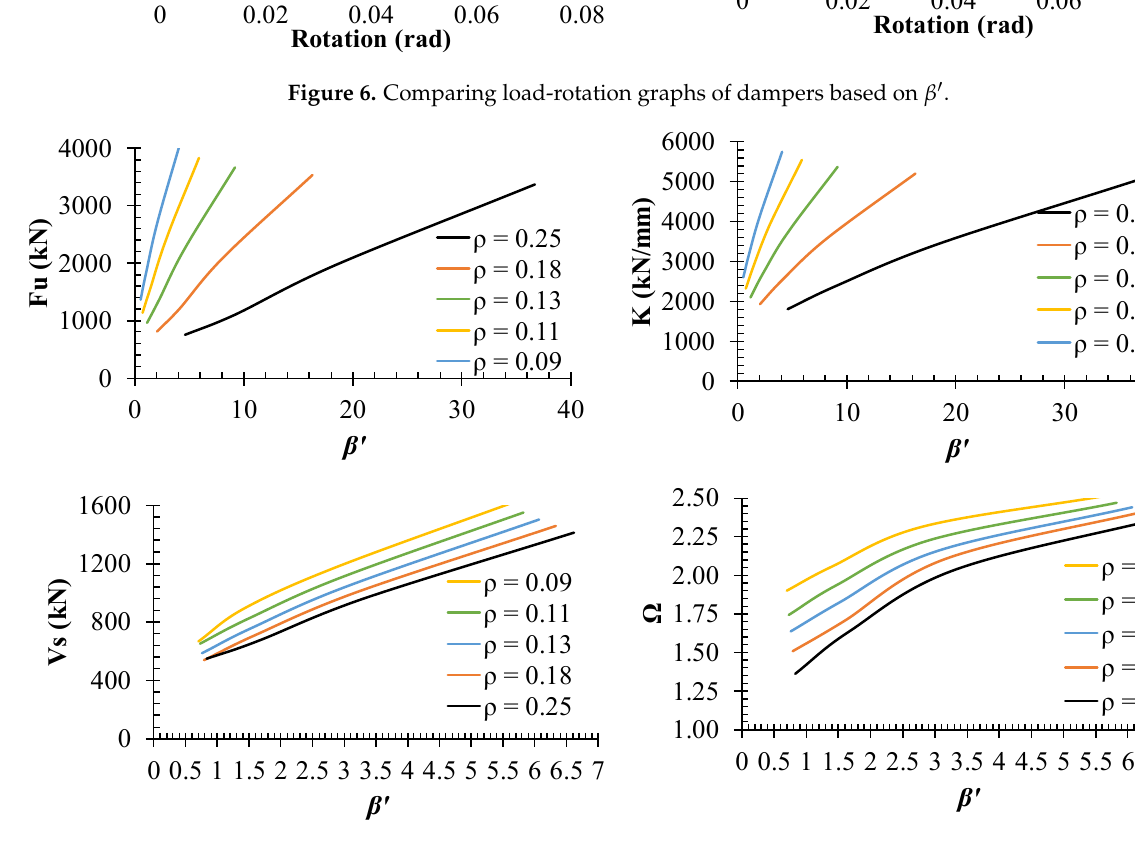
Ω versus β (cid:48)